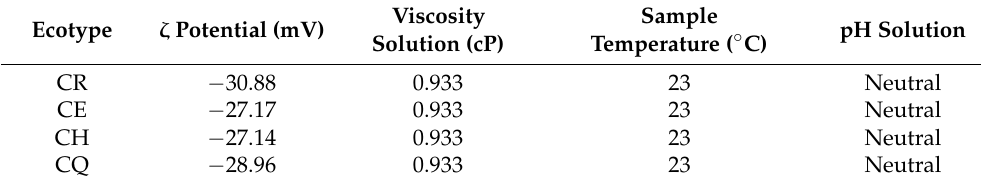
Table 9. ζ potential of spray-dried